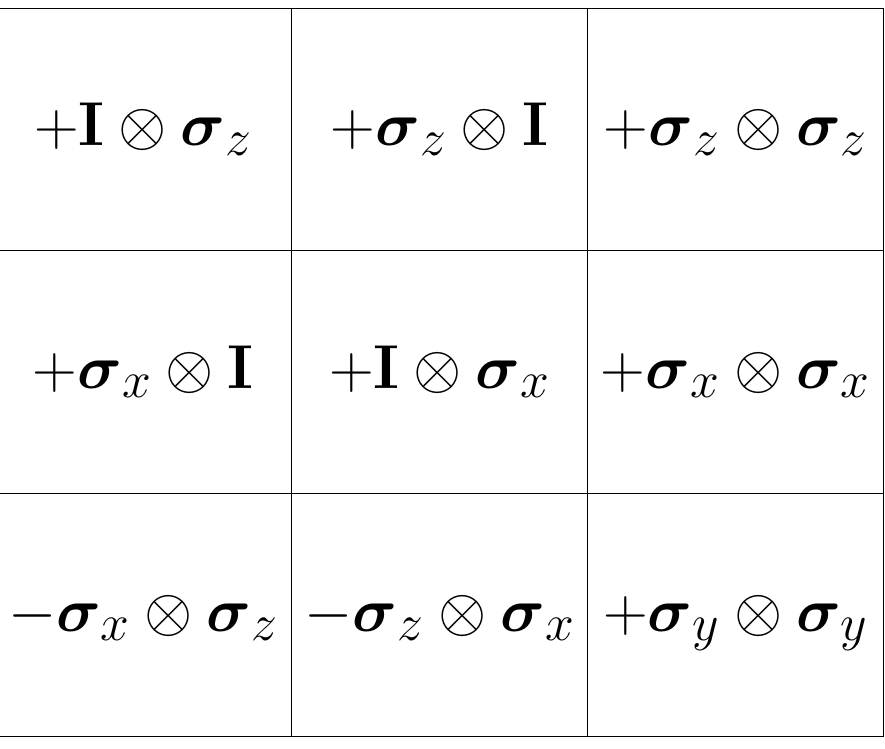
Table 3 . A quantum optimal winning strategy to fill the 3 × 3 table. σ x , σ y and σ z are Pauli matrices defined in (2.6), and I is the identity matrix of size 2